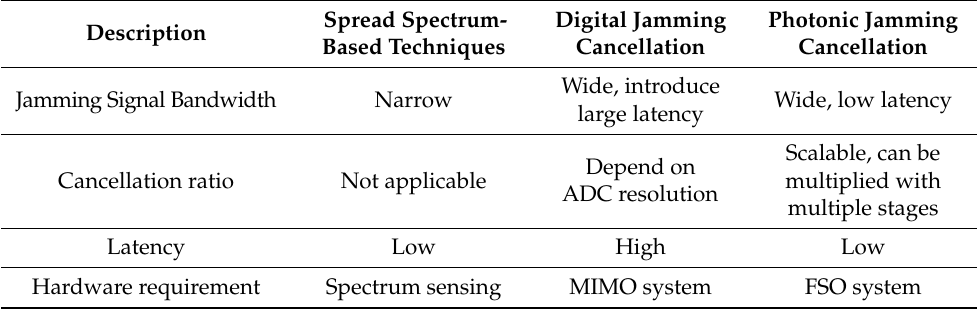
Table 1. Comparison of different anti-jamming techniques. ADC: analog to digital conversion; MIMO: multiple-input multiple-output; FSO: free space optical communication. Spread Spectrum- Digital Jamming Photonic Jamming Description Based Techniques Cancellation Cancellation Wide, introduce Wide, low latency Jamming Signal Bandwidth Narrow large latency Scalable, can be Depend on multiplied with Cancellation ratio Not applicable ADC resolution multiple stages Latency Low High Low Hardware requirement Spectrum sensing MIMO system FSO